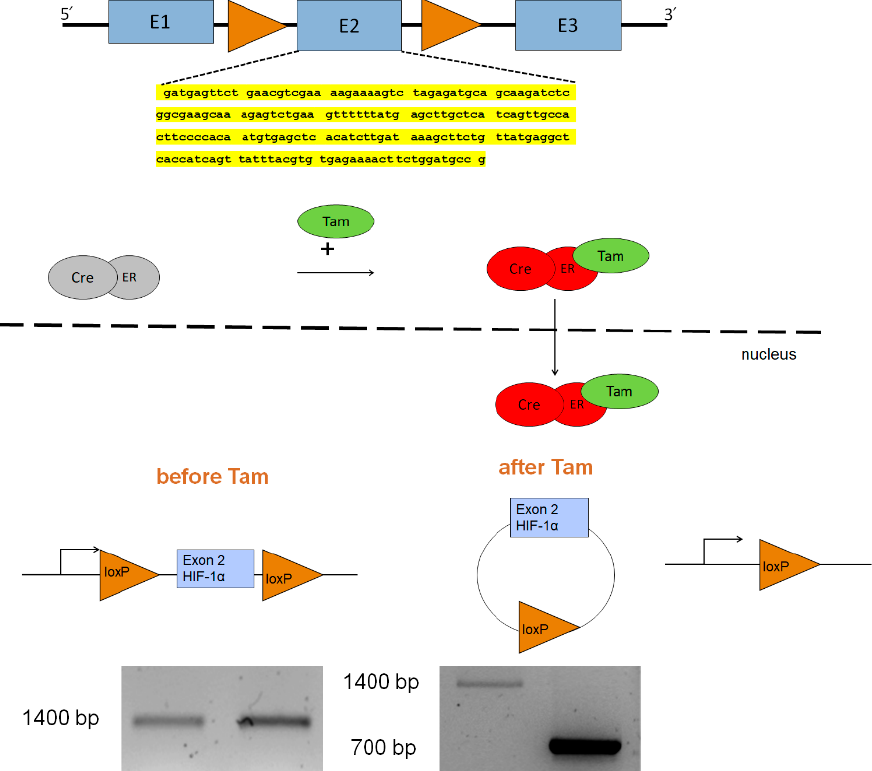
Figure 1. Strategy for generation of a conditional knockout of Hif1a. Mice were used which carry loxP sites flanking exon 2 (E2) of Hif1a [26]. Recombination was accomplished by tamoxifen induced expression of Cre from a ROSA26_CreERT2 locus. Loss of exon 2 resulted in the inability of HIF-1 α to bind to DNA and HIF-1 β . PCR genotyping demonstrated a shortened amplification product in the Hif1a fl/fl Cre-ER ki/wt (Cre(ki)) mice after Tam treatment compared to the Hif1a fl/fl Cre-ER wt/wt (Cre(-)) mice, indicating the excision of E2. Yellow highlight: Nucleotide sequence of exon 2 of HIF-1 α (GenBank AH006789.2)